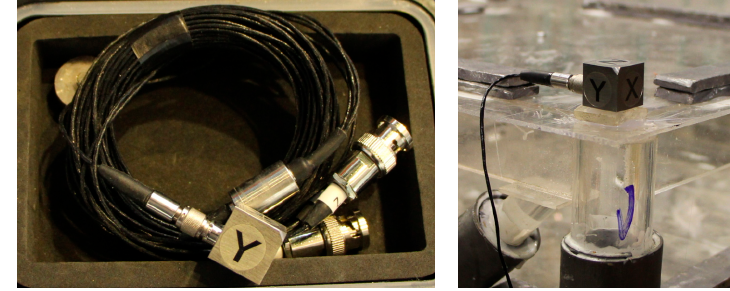
Figure 6. The experimental layout of the acceleration sensor.